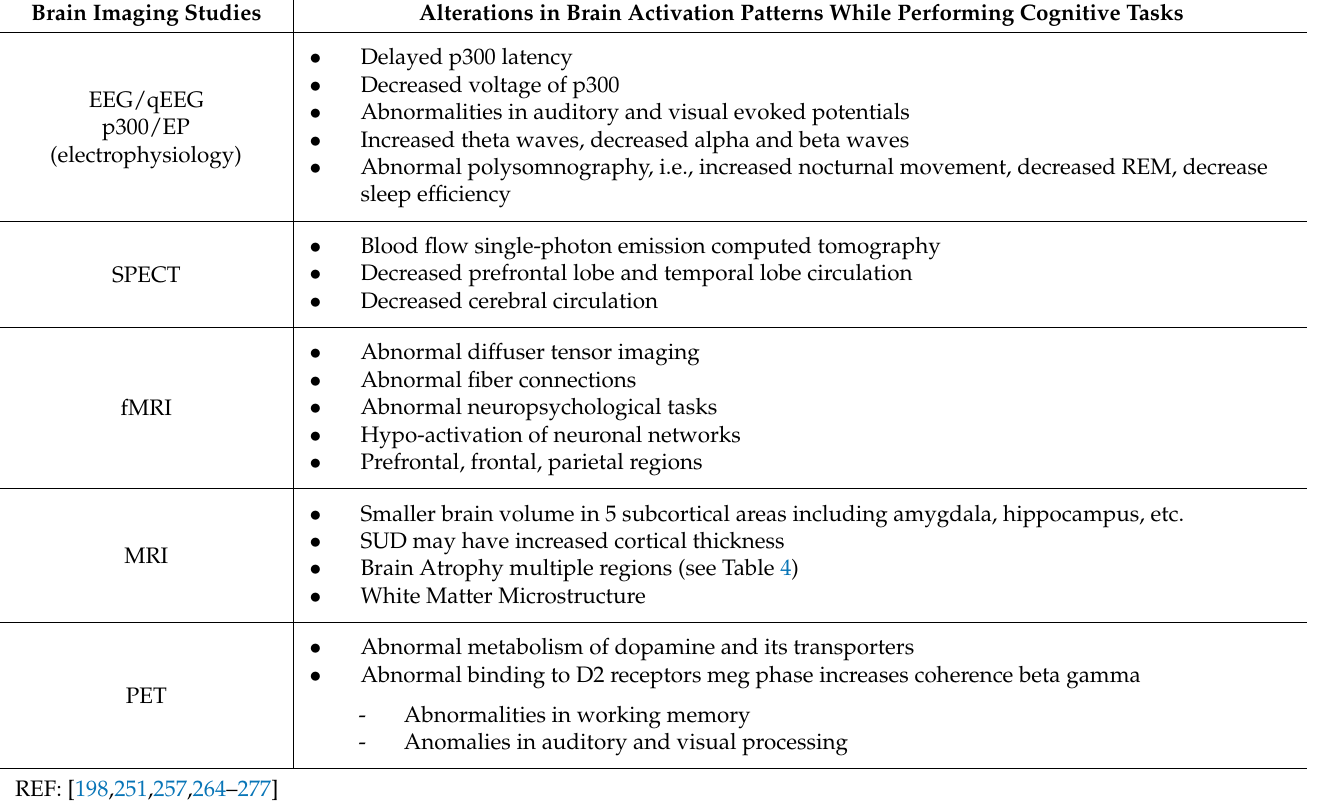
Table 7. Brain neuroimaging.